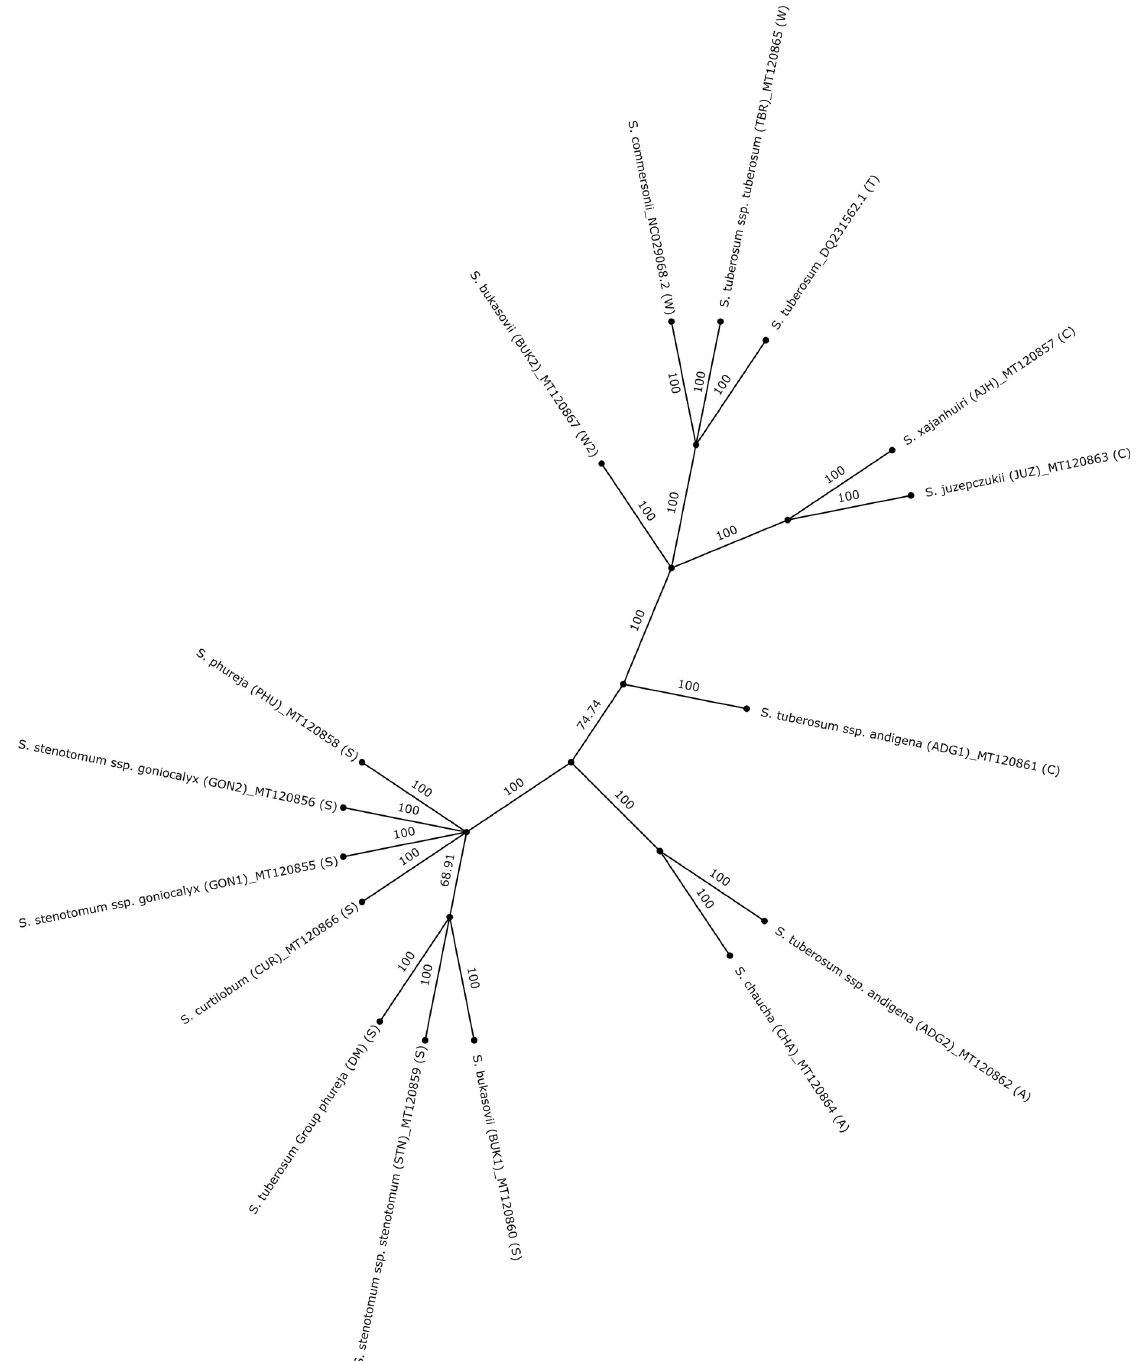
Fig 8. Phylogenetic tree of 16 plastomes. A phylogenetic tree was constructed using complete plastomes of sixteen potato accessions (without the IRb repeat). Plastome types of three other potato species were also determined (types are shown in brackets at the end). It is interesting to see that all the plastomes are grouped together according to their